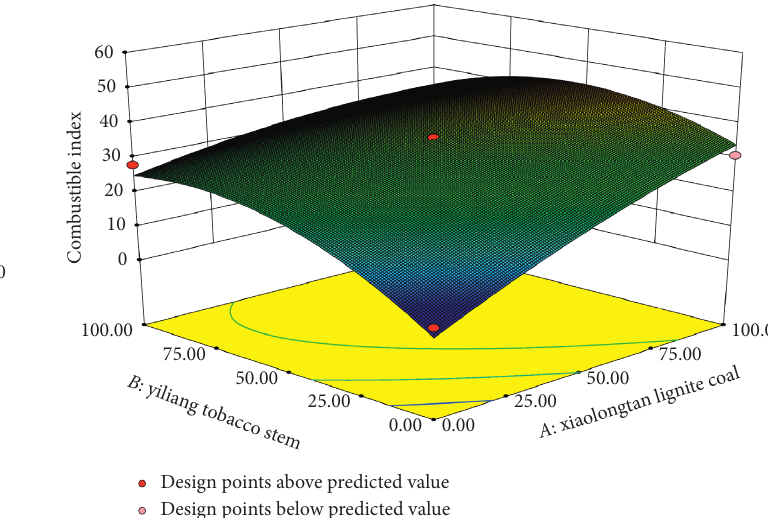
Figure 11: Response surface of the relationship between combustible index of mixing fuels and mass ratios of Xiaolongtan lignite and Yiliang tobacco rod.